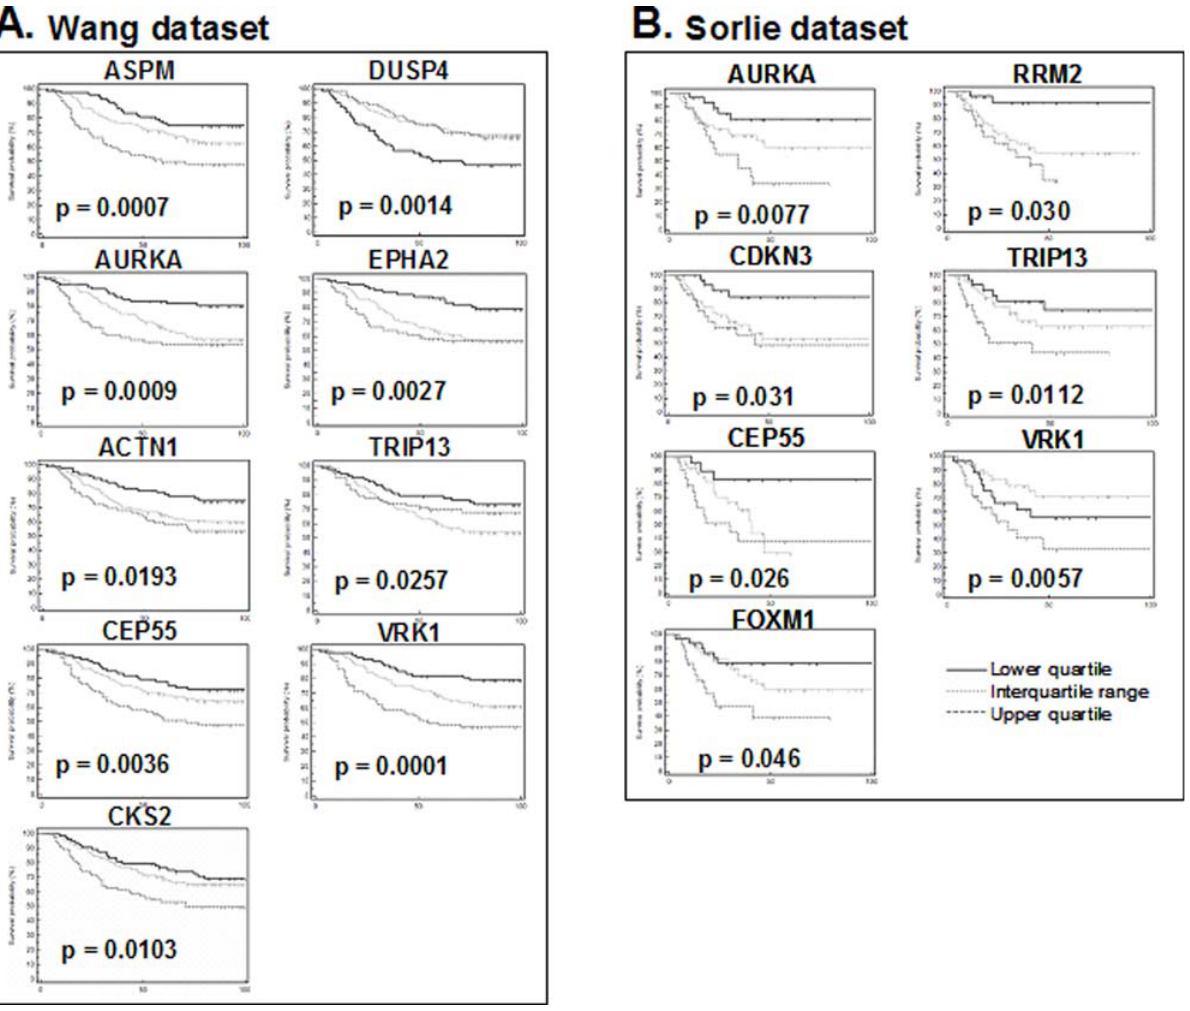
Figure 2. Kaplan-Meier curves of the individual genes that accurately predicted patient prognosis (p , 0.05). A. Results for individual genes in the dataset of Wang, et al. , using patient relapse as the endpoint. B. Results for individual genes in the dataset of Sorlie, et al. , using patient survival as the endpoint.